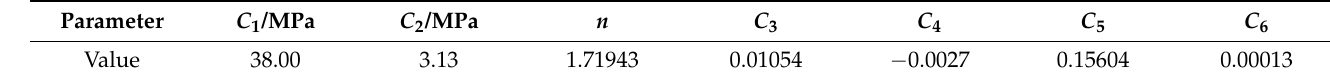
Table 2. Parameters for the modified Zerilli–Armstrong model.